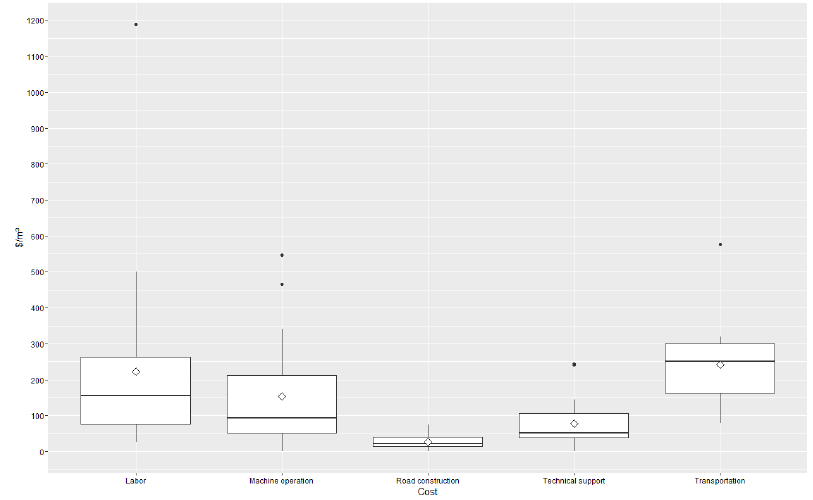
Figure 5. Boxplot of sampled variable cost for the central south region (n = 20) summarizing distribution, mean, median, skewness and outliers. Energies 2017 , 10 , 1192